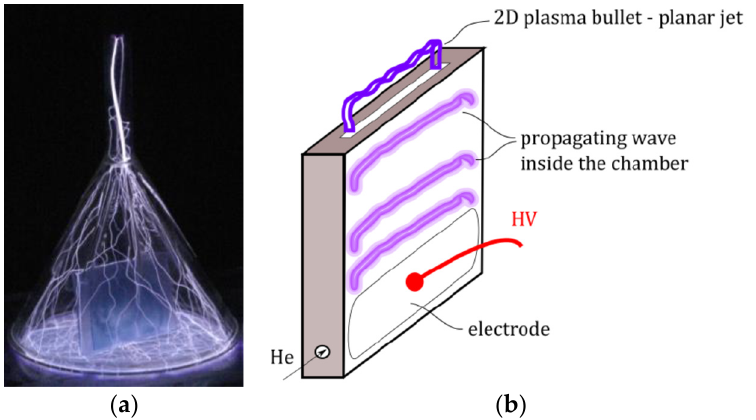
Figure 4. ( a ) Cone-shaped nozzle covering an APPJ-treated vertical object and suppression of air mixing. Nozzle diameter: 64 mm; exposure time: 1.7 ms. Reprinted/adapted with permission from Ref. [34]. Copyright 2018, Elsevier B.V. ( b ) Sketch of a planar APPJ setup. Reproduced from [35]. Published by arXiv.org under a non-exclusive license.